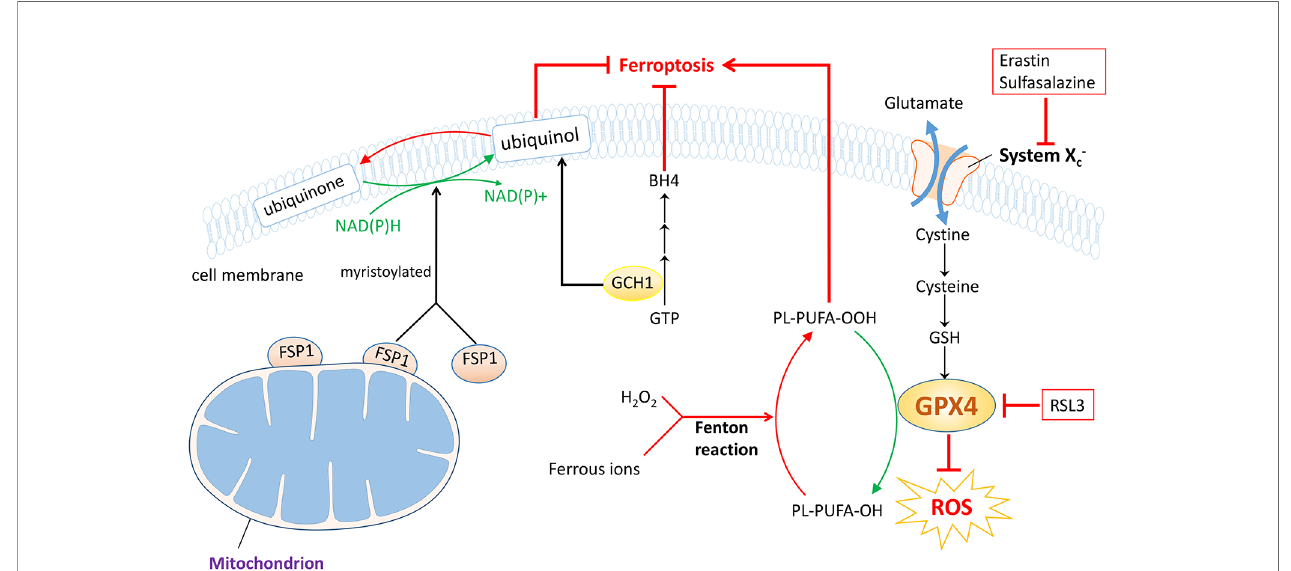
FIGURE 2 | Three prestigious protection pathways implicated in ferroptosis. Of note GPX4 protection pathway is the famous one. With the help of GSH, GPX4 downregulates ROS and inhibits forthcoming ferroptosis, which could be suppressed by RSL3. System X − c , the cystine/glutamate antiporter, also functions to synthesize GSH during this process, and can be counteracted by erastin or sulfasalazine. In the FSP1 protection pathway, the myristoylated FSP1 catalyzes the reduction of CoQ10 to ubiquinol, consuming NAD(P)H and mitigating ferroptosis. In the GCH1 protection pathway, GCH1 acts as a rate-limiting enzyme to manage the biosynthesis of BH4, while regulating ubiquinol as well. Therefore, ferroptosis progression is blocked. However, the Fenton reaction, the interaction between ferrous ion and H 2 O 2 , triggers the occurrence of